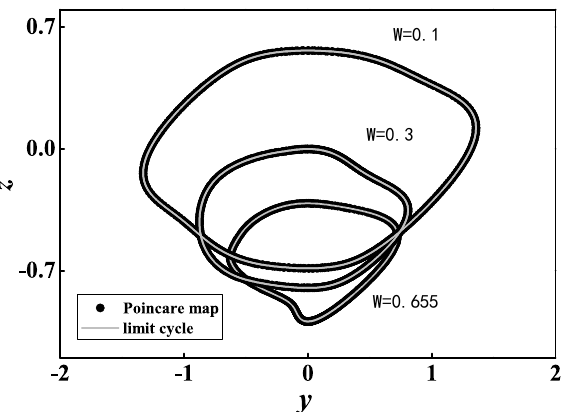
Figure 7. Overlaps of Poincare mappings with τ = 2 k π + π /2 ( k ∈ N ∗ ) and the corresponding limit cycles on the Poincare